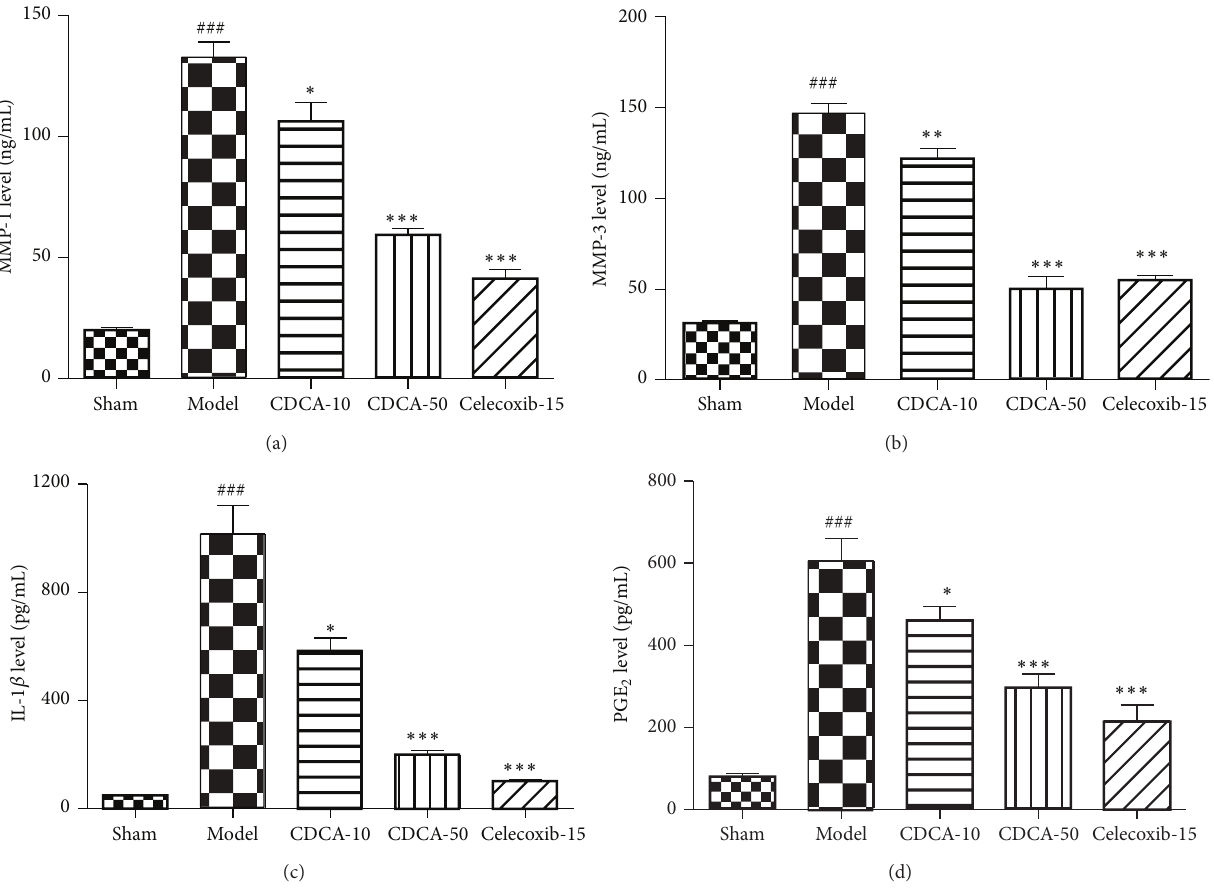
Figure 5: The levels of MMP-1 (a), MMP-3 (b), IL-1 𝛽 (c), and PGE 2 (d) in synovial fluid from knee joints were measured by ELISA. Each reported value is a mean ± SEM ( 𝑛 = 8 ); ### 𝑃 < 0.001 , compared with the sham-operation group; ∗ 𝑃 < 0.05 , ∗∗ 𝑃 < 0.01 , and ∗∗∗ 𝑃 < 0.001 , compared with the model group. Similar results were observed in two separated